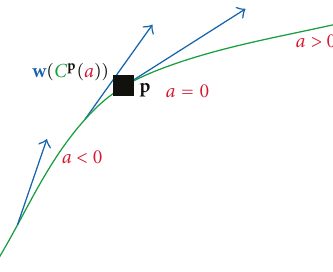
Figure 6: Integral curve C p ( a ) of vector fields w : Ω → R 2 .